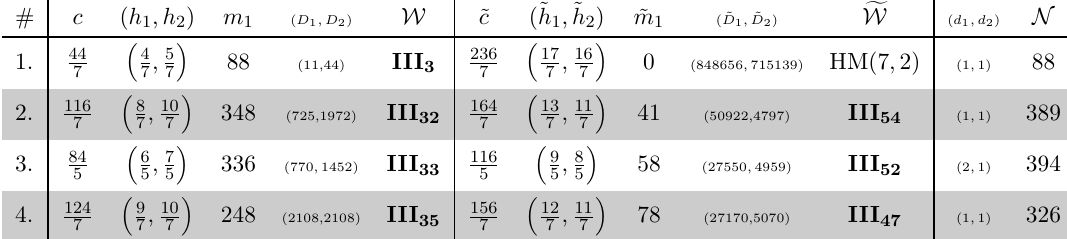
Table 24. IVOA-type pairings, c H = 40 with ( n 1 , n 2 ) = (3 , 3) . The meromorphic character is j 2 3 ( j − 1240 + N ) with N given in the last column of the table.